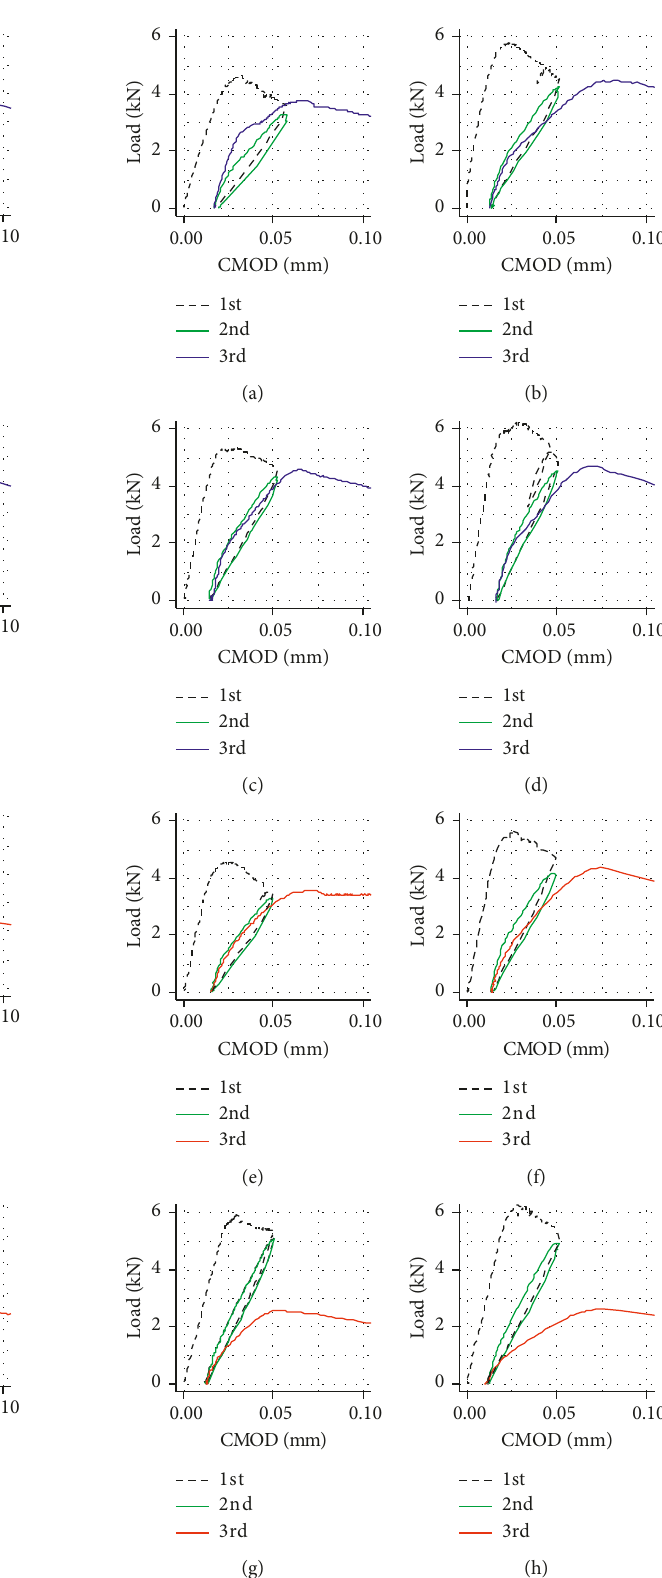
Figure 5: Typical load-CMOD curves of PE concrete: (a) PE-7– 28W, (b) PE-28–49-W, (c) PE-49–70-W, (d) PE-91–112-W, (e) PE- 7–28-A, (f) PE-28–49-A, (g) PE-49–70-A, and (h) PE-91–112-A.